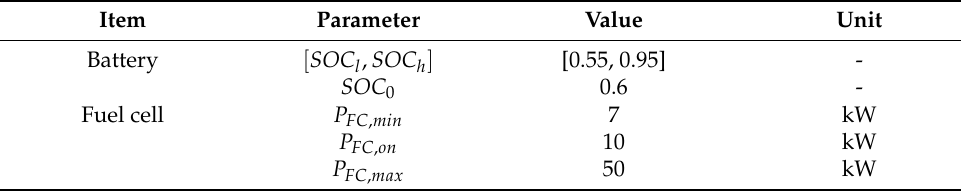
Table 4. Baseline mode-based control strategy parameters.